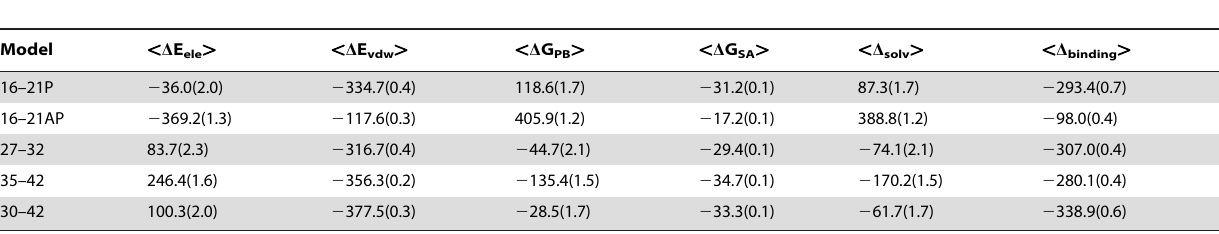
Table 2. Summary of the MM/PBSA Energy (kcal/mol) Component Analysis of the Bilayer Systems of the MD Simulation of the Double Layer Models of A b segmental polymorphism.